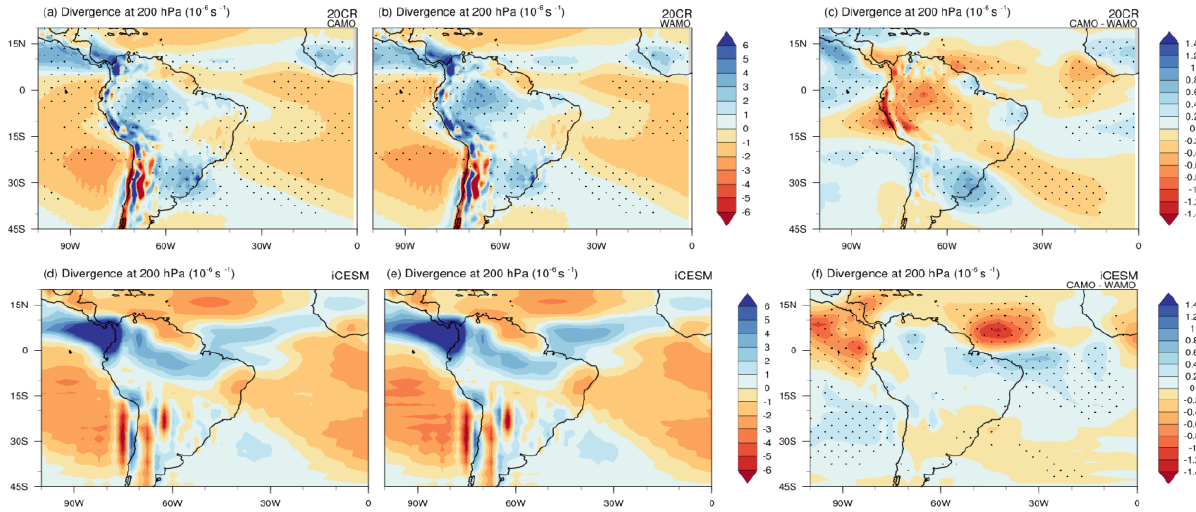
Figure 5. Divergence at 200 hPa for the cold Atlantic Multidecadal Oscillation (CAMO) and the warm Atlantic Multidecadal Oscillation (WAMO) phases, as well as the differences between both phases from reanalysis ( a – c ) 20CRv3 and ( d – f ) iCESM model. Stippling areas represent statistically significant (Student’s t test at 95%) composites ( a , b ) and differences ( c , f ).